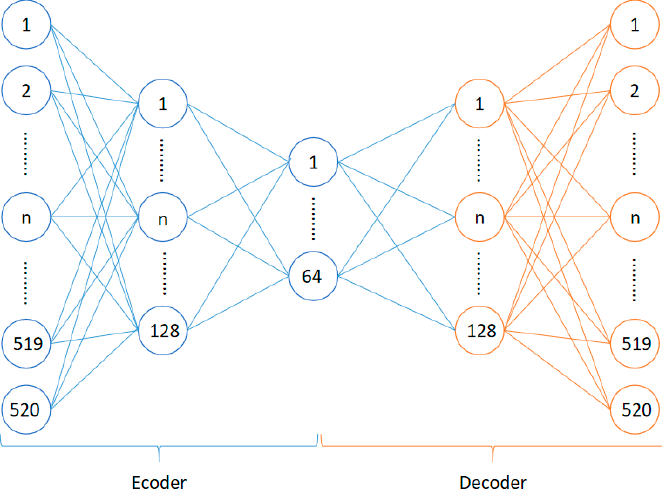
Figure 3. Encoder and Decoder. The output of each layer is used as the input of the next layer, the encoder can achieve dimensionality reduction processing, and the decoder can achieve dimensionality increase processing.